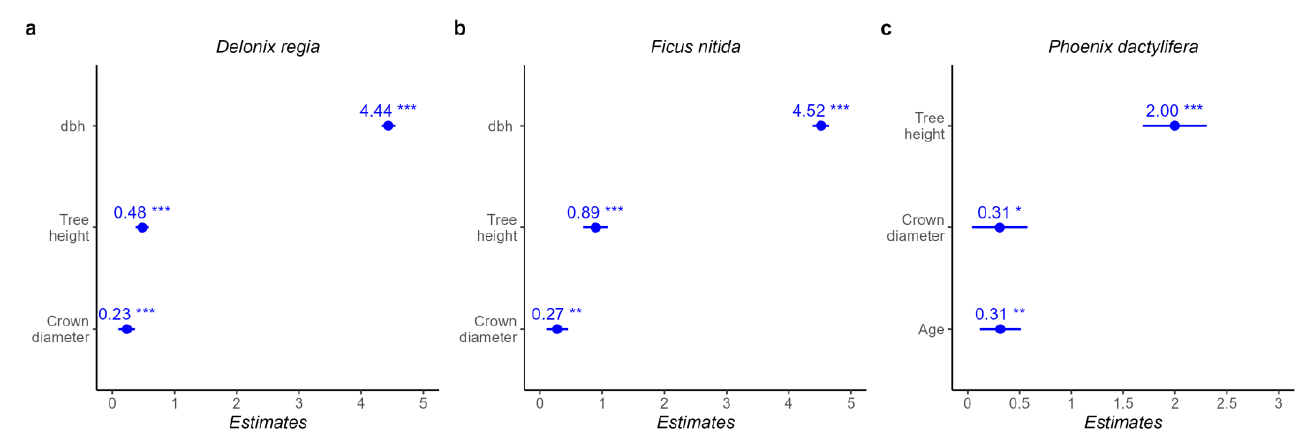
Figure 3. Impact of the tree structural variables on above-ground biomass carbon storage of three tree species in three plots using a linear mixed model. the p -value (with levels of significance indicated by symbols such as ***, ** and *) for each ANOVA shows the significant impact of the tree structure variables and above-ground biomass carbon storage for the species.